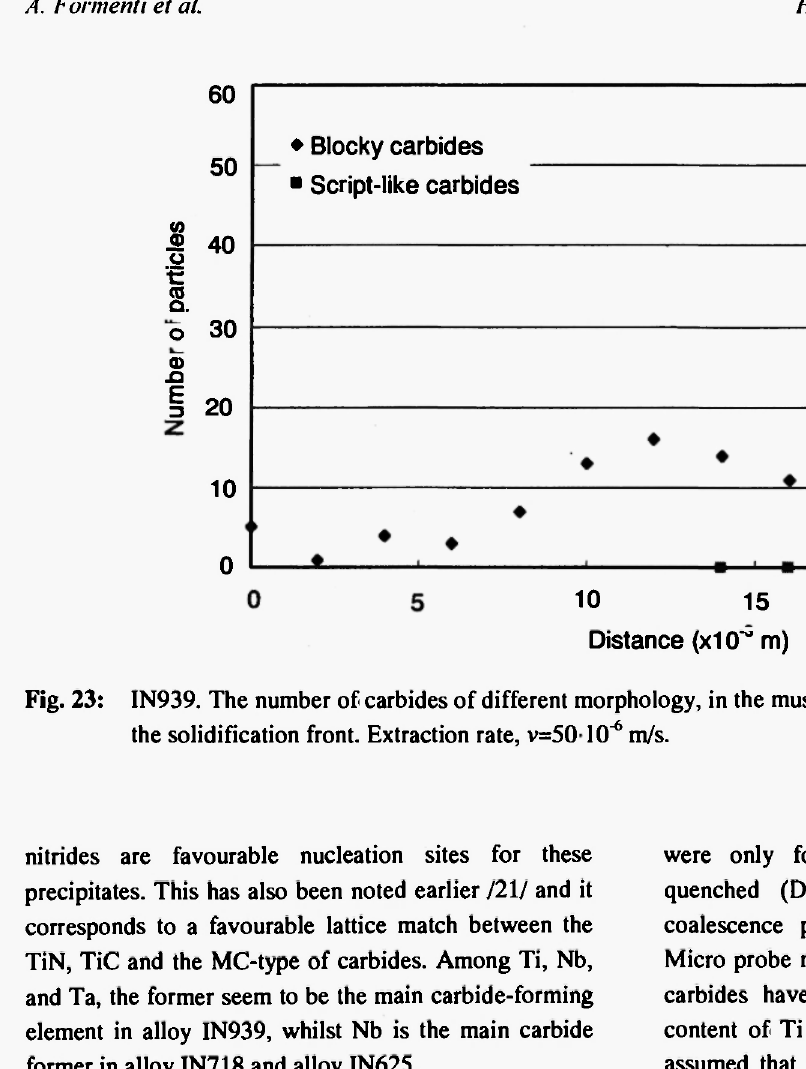
nitrides are favourable nucleation sites for these were only found in the directional solidified and (DSQ) samples. A transformation or